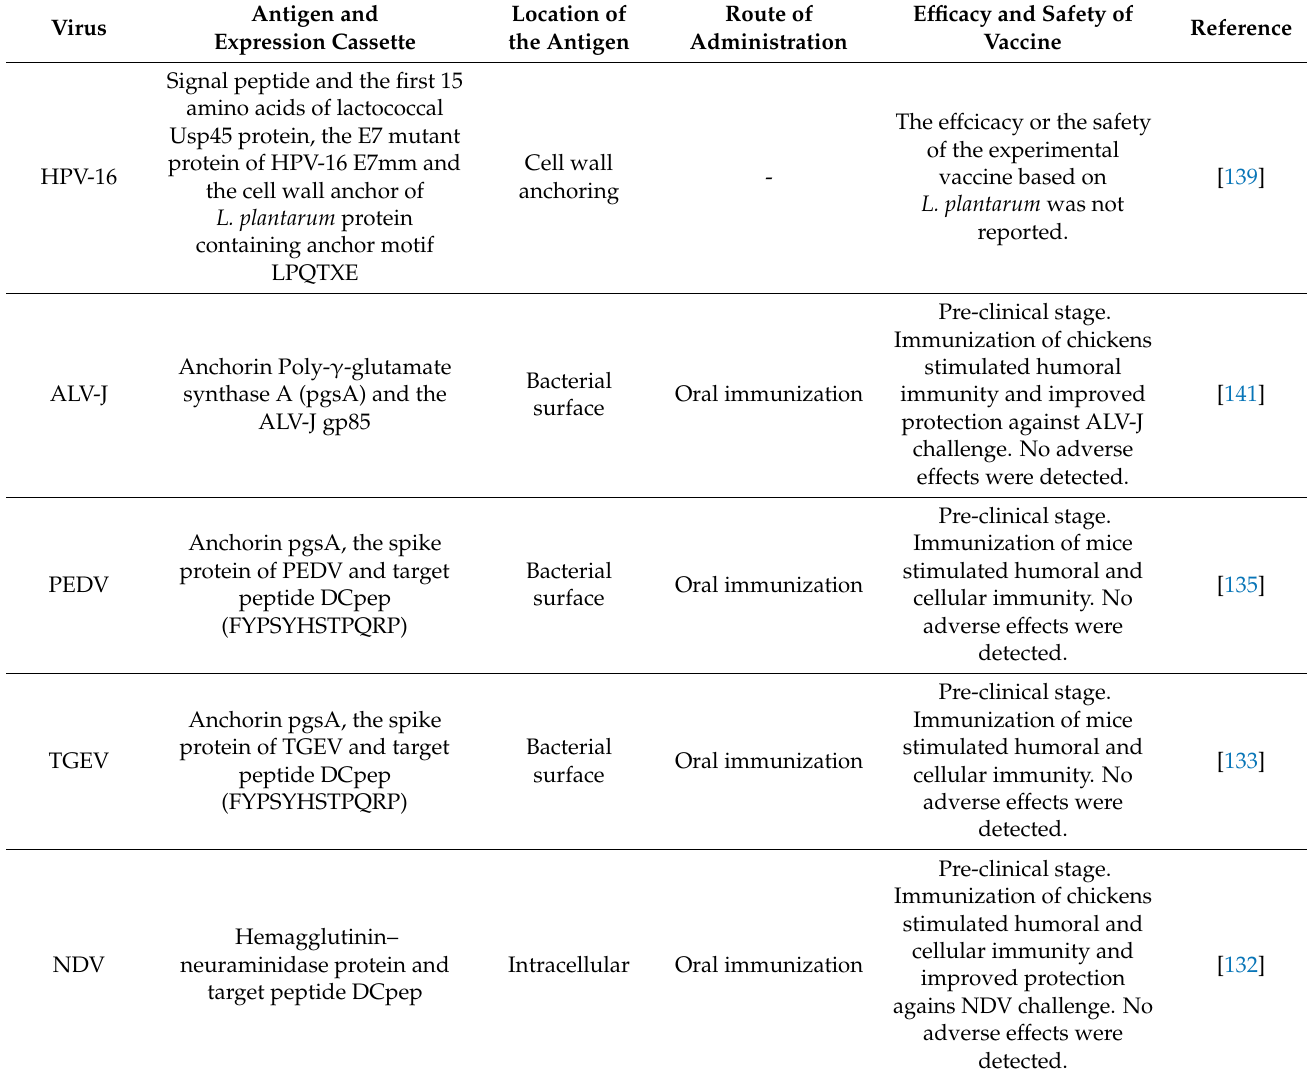
Table 1. Summary of viral antigens successfully expressed in Lactiplantibacillus plantarum . Human papillomavirus type-16 (HPV-16), J subgroup Avian Leukosis Virus (ALV-J), porcine epidemic diarrhea virus (PEDV), transmissible gastroenteritis virus (TGEV) and Newcastle disease virus